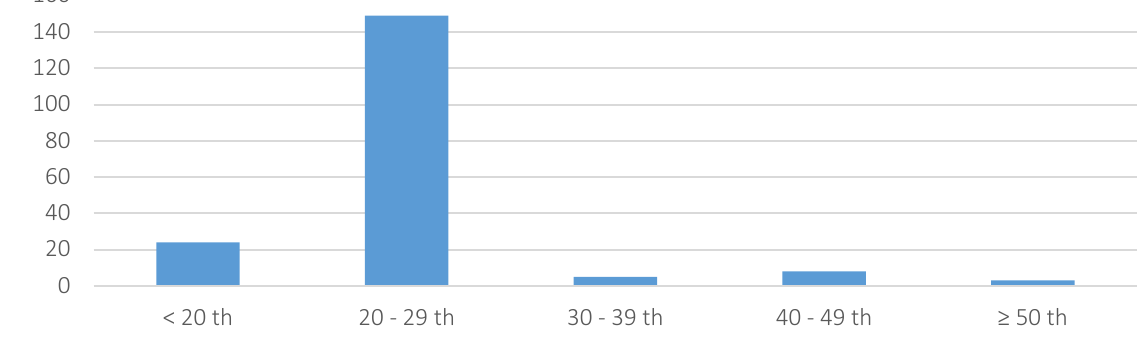
Figure 1. Respondent Profile – age range,